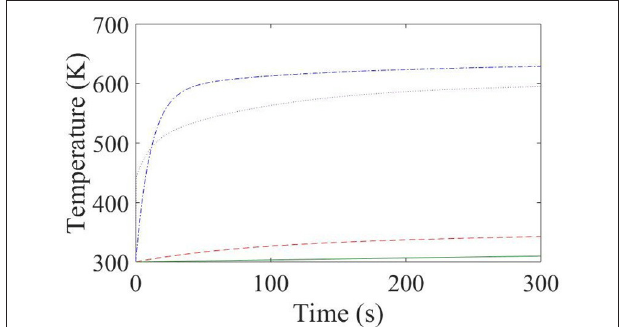
FIGURE 5 | Lumped thermal model results for temporal heating in Pocket Rocket, showing temperature of the alumina tube (node 1—dot-dashed blue line), aluminum housing (node 2—dashed red line), and the measured outer surface temperature of the aluminum housing (node 3—solid green line) for the first 300 s of operation. Measured gas temperature near the wall is also shown as a dotted purple line for reference.